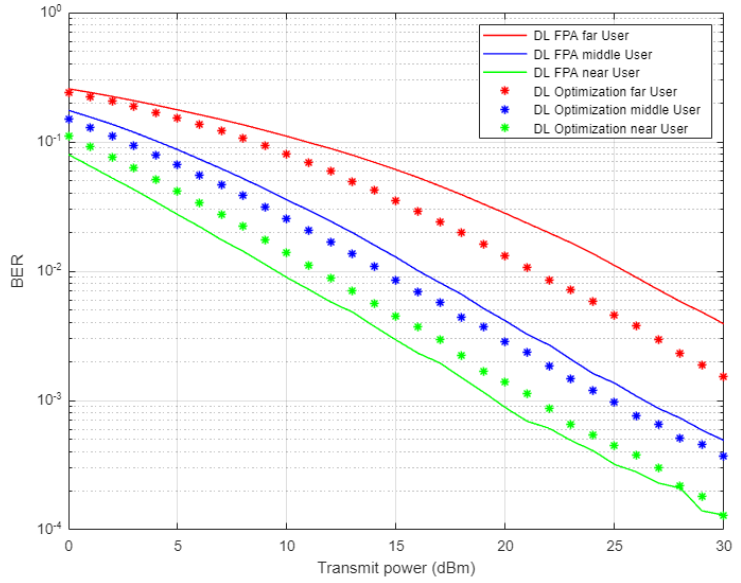
Figure 12. BER vs. power for DL-based optimized and FPA power schemes (Rayleigh Channel).